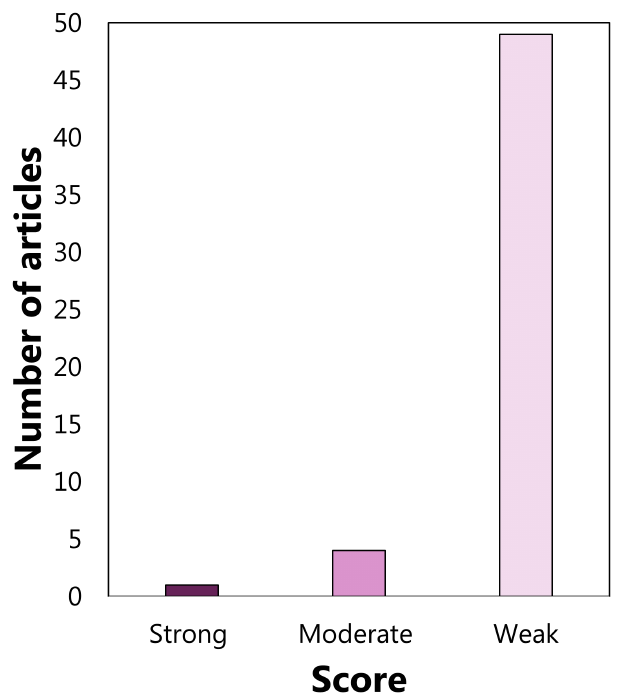
Figure 13. Global Rating of articles on